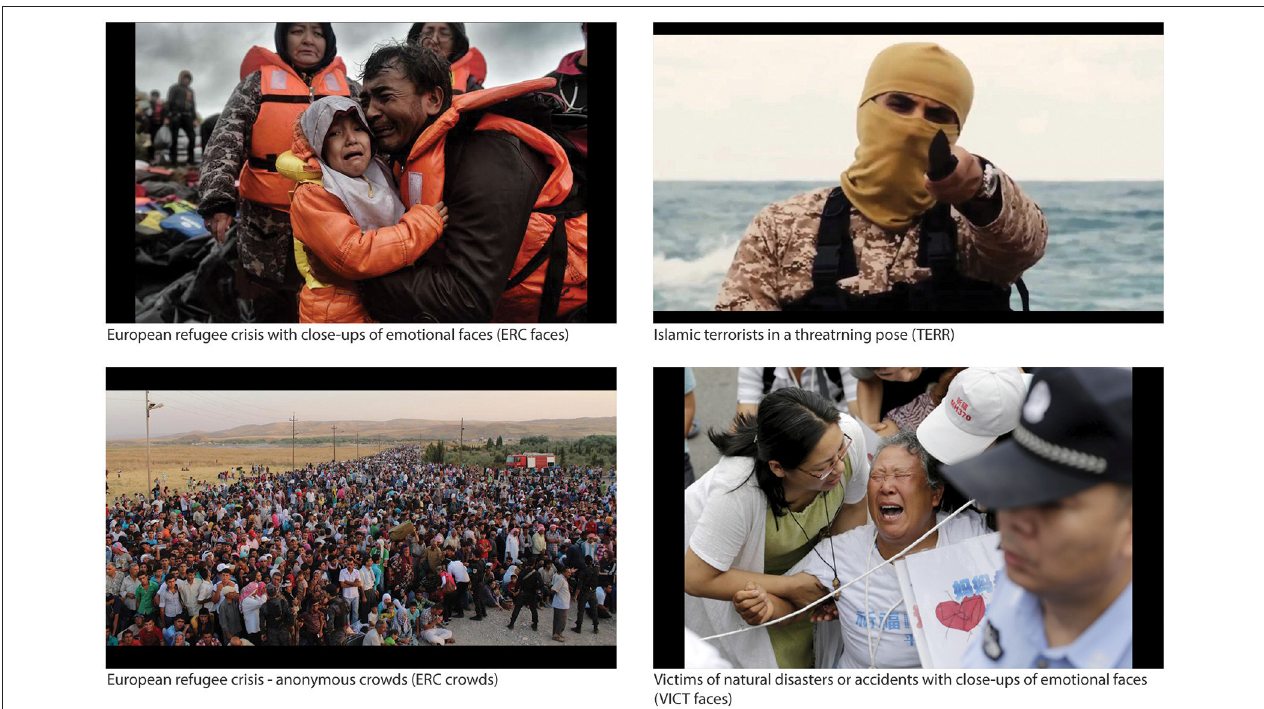
FIGURE 2 | Schema of sample stimuli. (i) Photographs of refugees with close-ups of their emotional faces (ERC FACES); (ii) photographs depicting anonymous crowds of refugees (ERC crowds); (iii) photographs of Islamic terrorists in threatening and violent poses (TERR); and (iv) photographs of victims of another conflict, disaster, or accident with close-ups of their emotional faces (VICT FACES).